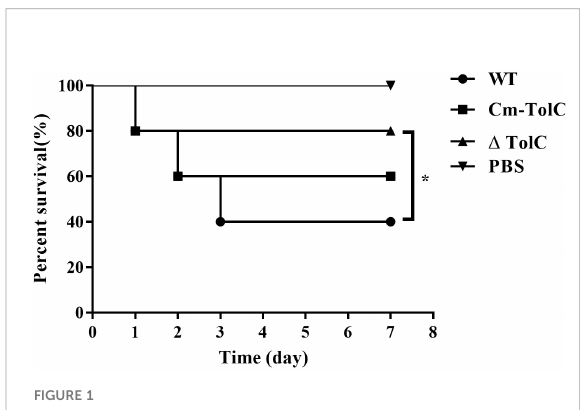
FIGURE 1 Survival curves for Kunming mice infected with the WT, D TolC, and Cm-TolC strains. Six-week-old Kunming mice were injected intraperitoneally with 1×10 7 CFU of bacteria, and their survival was monitored over a 7-day period. Data were analyzed using the log rank test. Statistically signi fi cant difference is indicated as * p <